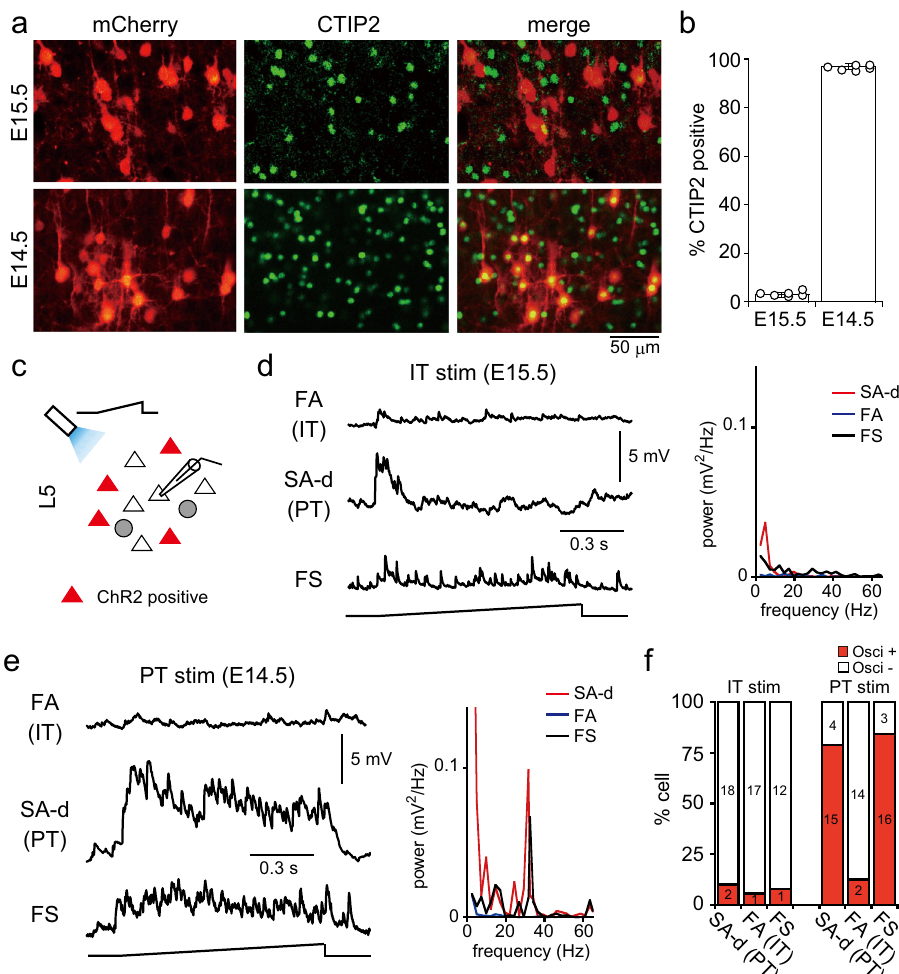
Fig. 4 Oscillations induced by speci fi c PC subtype stimulation. a CTIP2 expression in L5 PCs transfected with mCherry by electroporation at E15.5 or E14.5. b Proportion of CTIP2-positive cells among PCs expressing mCherry (six rats, respectively). Data are expressed as mean ± SD. c Schema of L5 photostimulation and recording from non-labeled cells. d Recordings from L5 cell-subtypes during ramp-shaped photostimulation to L5 in slices obtained from rats electroporated with ChR2 at E15.5 (stimulation of IT cell population). PC fi ring subtypes: SA-d (slow spiking adaptation with initial doublet spikes) type, overlapped considerably with PT cell population; FA (fast-spiking adaptation) type, overlapped with IT cell population. Right graph, power spectra of membrane potentials during stimulation. e Membrane potentials of L5 subtypes during photostimulation in slices obtained from rats electroporated with ChR2 at E14.5 (stimulation of PT cell population). Right, power spectra. f Proportion of L5 cells exhibiting oscillations upon photostimulation of IT or PT cell populations. Oscillations were adopted when the ratio of peak power (25 – 40 Hz band) to averaged power (45 – 55 Hz band) >10, and peak power (25 – 40 Hz band) >0.5 mV 2 Hz − 1